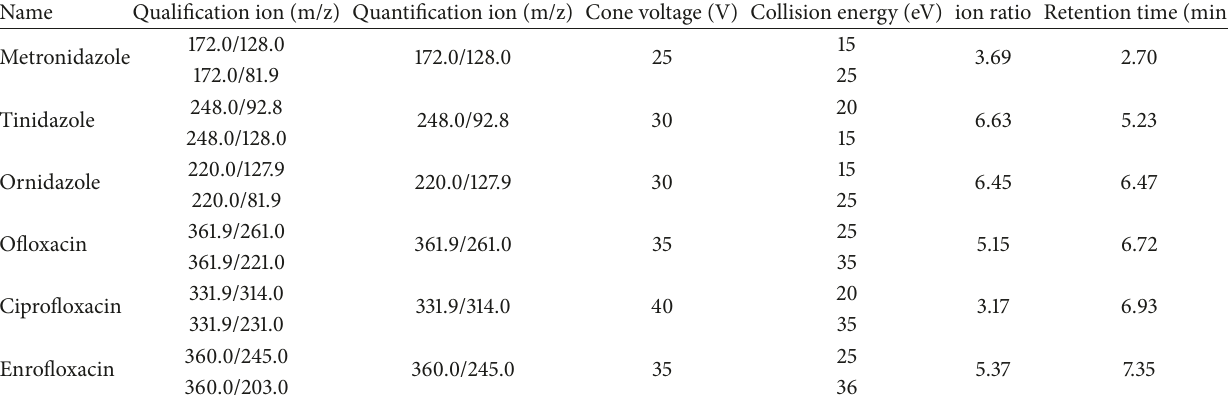
Table 2: Retention time and MS/MS conditions for the target